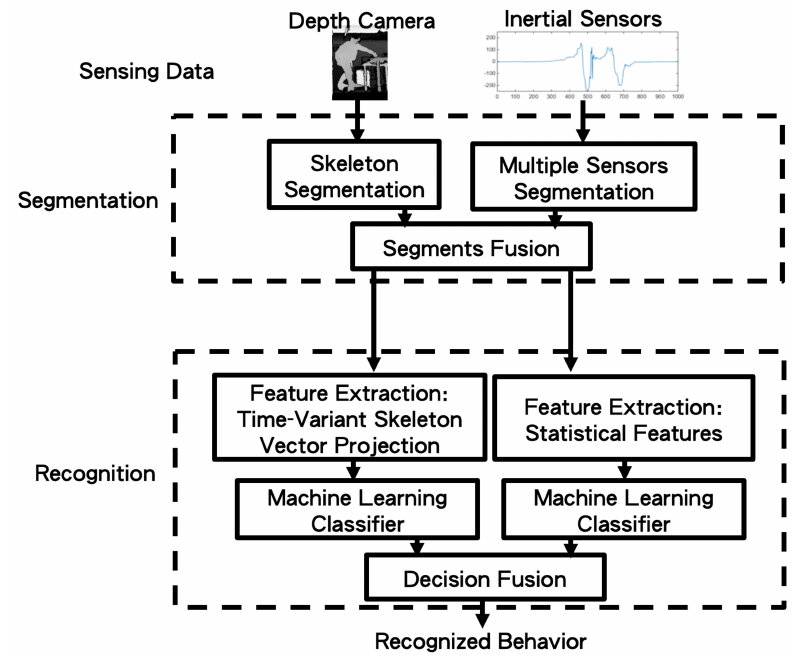
Figure 2. The system block diagram of the proposed